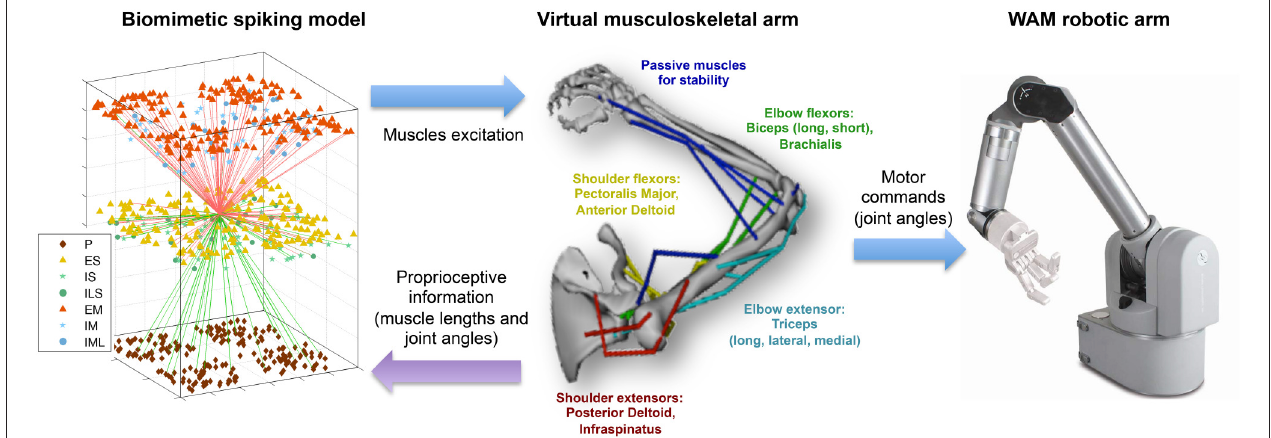
FIGURE 1 | Overview of the multiscale biomimetic system interfacing the spiking neuronal model with the virtual musculoskeletal arm and the Whole Arm Manipulator (WAM) robot. The virtual arm receives neural excitation from the biomimetic model and feeds back the joint angles, used in the reinforcement learning algorithm, and the muscle lengths, used as part of the sensorimotor mapping. The joint angles are also used to drive the WAM robotic arm in real time. For the neuronal model, all incoming (green) and outgoing (red) connections of a single ES neuron are shown, and the different cell types are shown in the legend. For the virtual arm, muscles are labeled in the corresponding